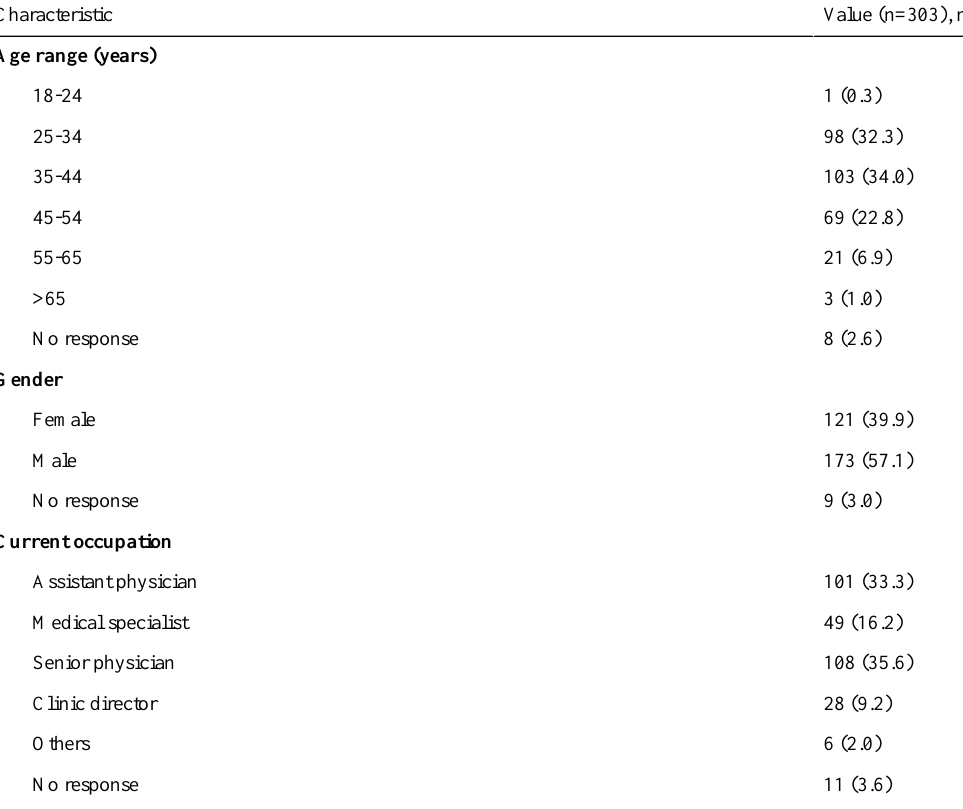
Table 2. Demographic and professional